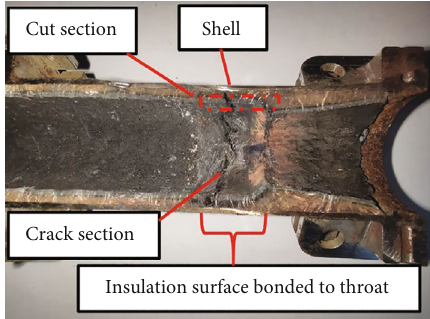
Figure 9: Sectional view of tail-pipe